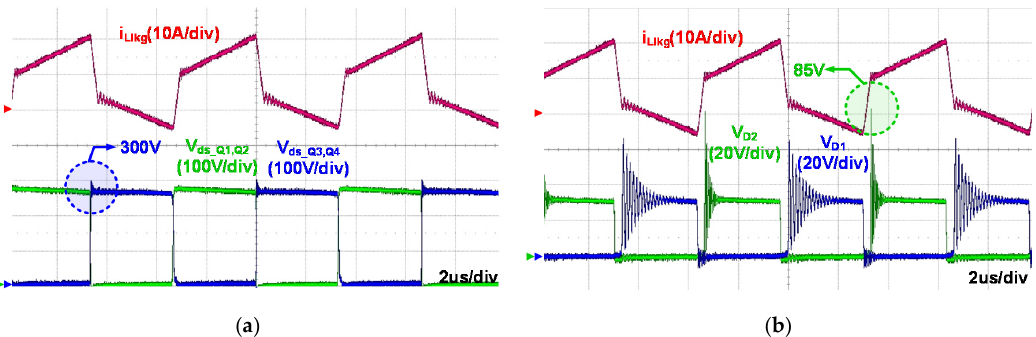
Figure 13. Key experimental waveforms at 270 V input and 100% load conditions ( D = 0.605). ( a ) Primary side key experimental waveforms. ( b ) Secondary side key experimental waveforms.